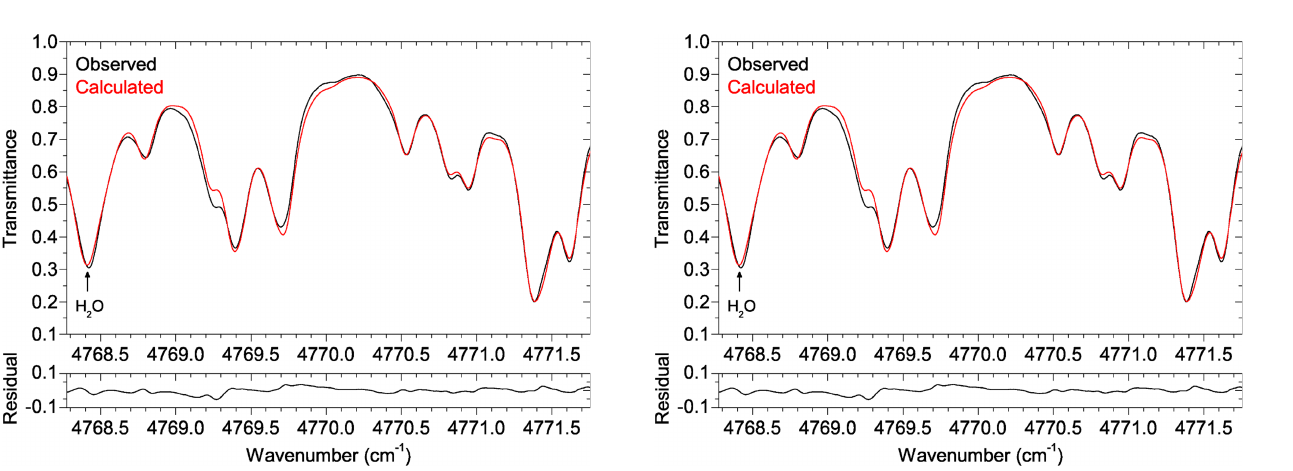
Fig. 4. Observed and calculated atmospheric transmittance spectra in the CO 2 region. All features arise from CO 2 absorption except for one, which is due to H 2 O (labelled).